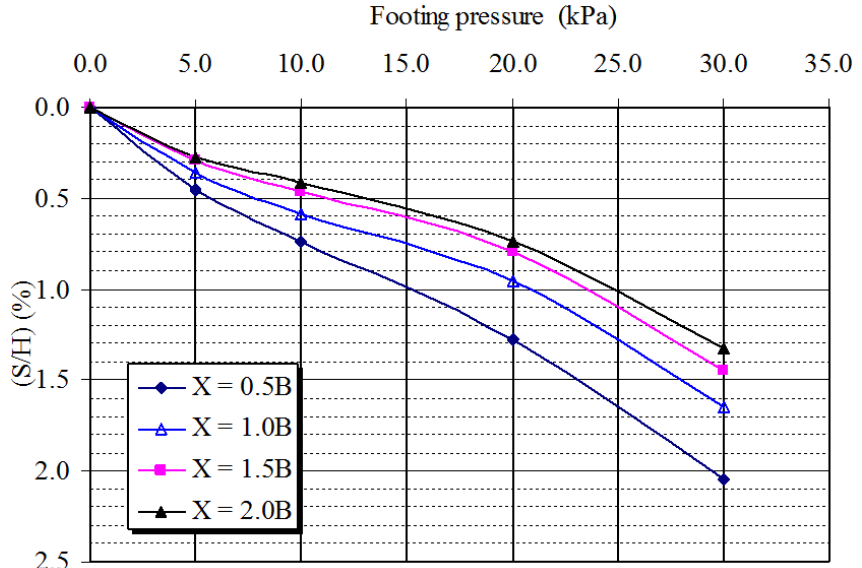
Figure 27. Influence of footing position on the settlement of the footing.